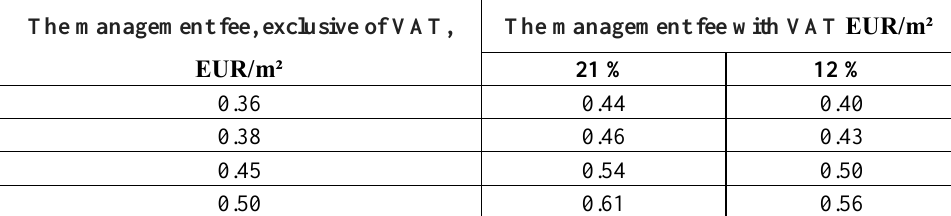
Table 2 . The Management Fee (made by the authors) The management fee, exclusive of